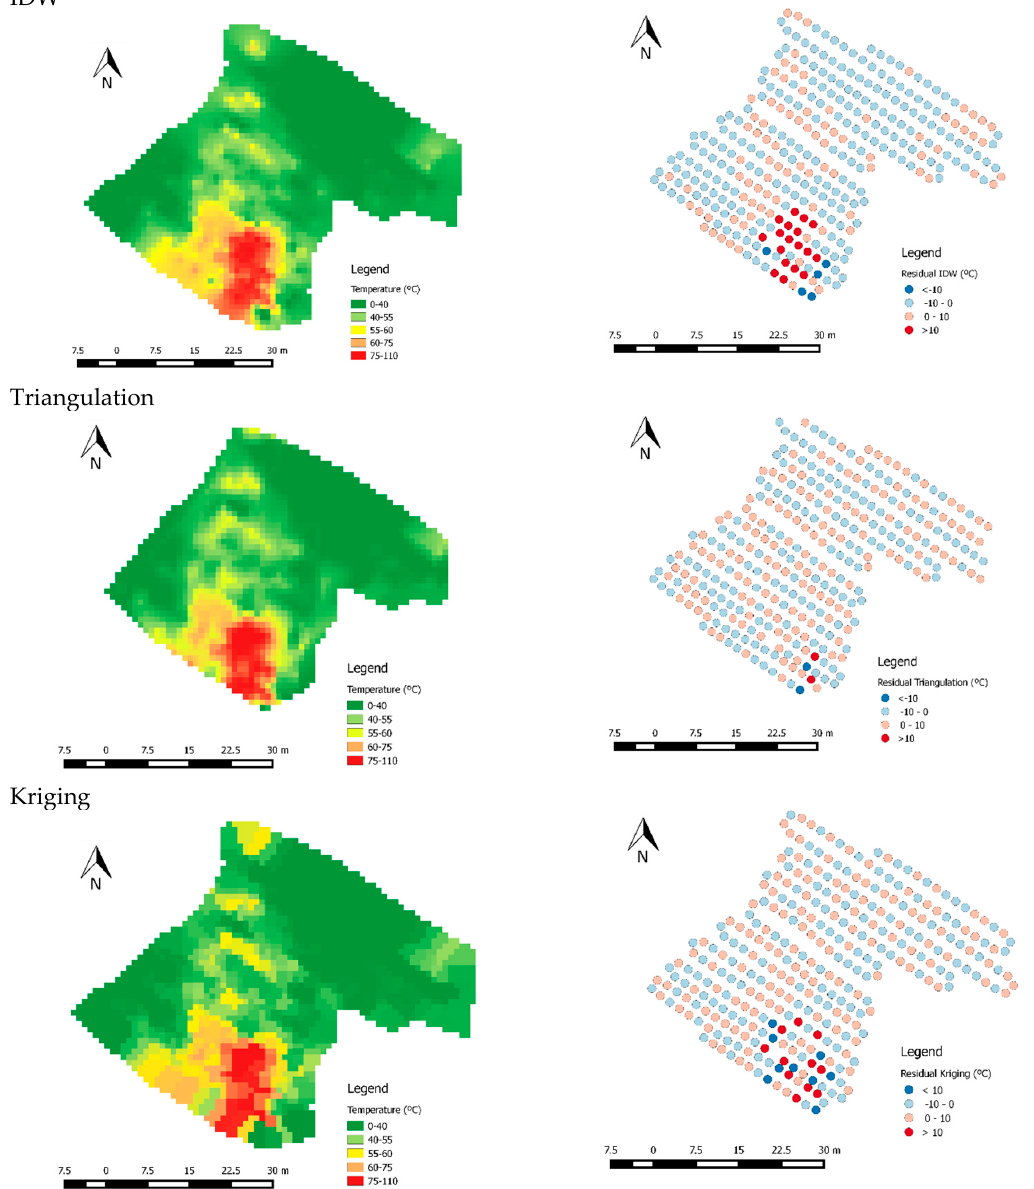
Figure 8. Interpolation method residuals.